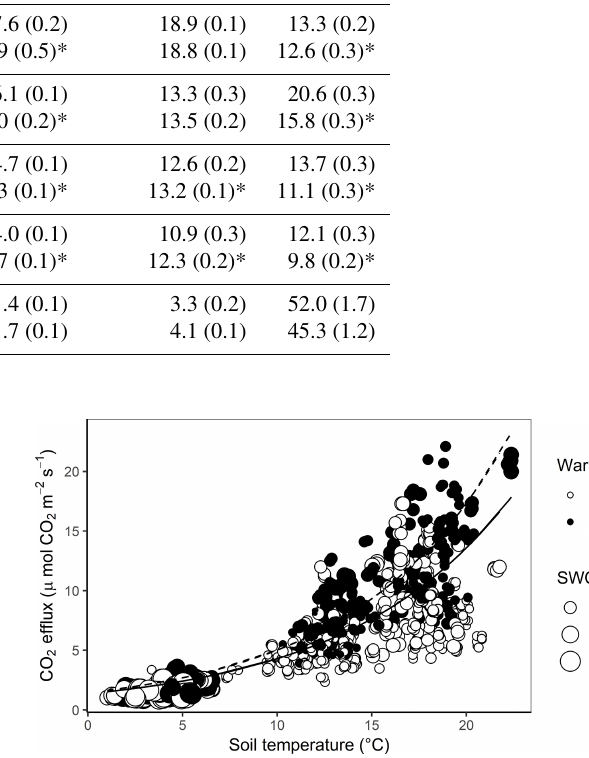
Figure 2. CO 2 efflux as a function of soil temperature and soil wa- ter content for warmed (W) and ambient (A) plots at Silver Plains from August 2017 to June 2018. The size of each point represents SWC%, with larger points corresponding to higher SWC. The re- gression lines indicate the relationship between CO 2 efflux and soil temperature at median SWC in ambient plots (solid line) and warmed plots (dashed